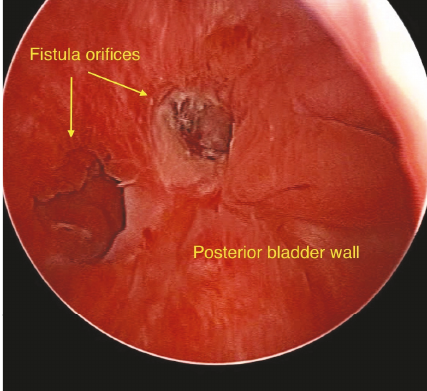
Figure 1: Cystoscopic view of two vesicouterine fistula (VUF) orifices in the posterior bladder wall.